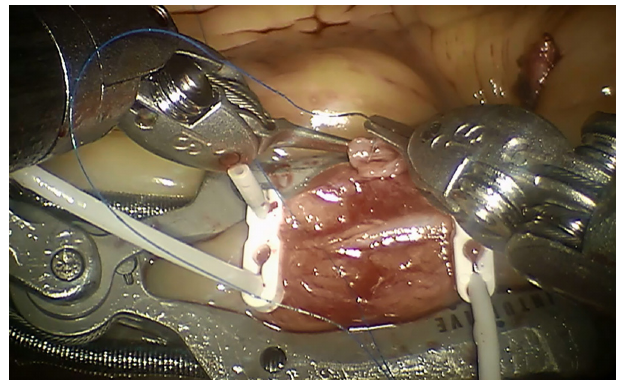
Fig. 2 - First stitch in the mammary artery.